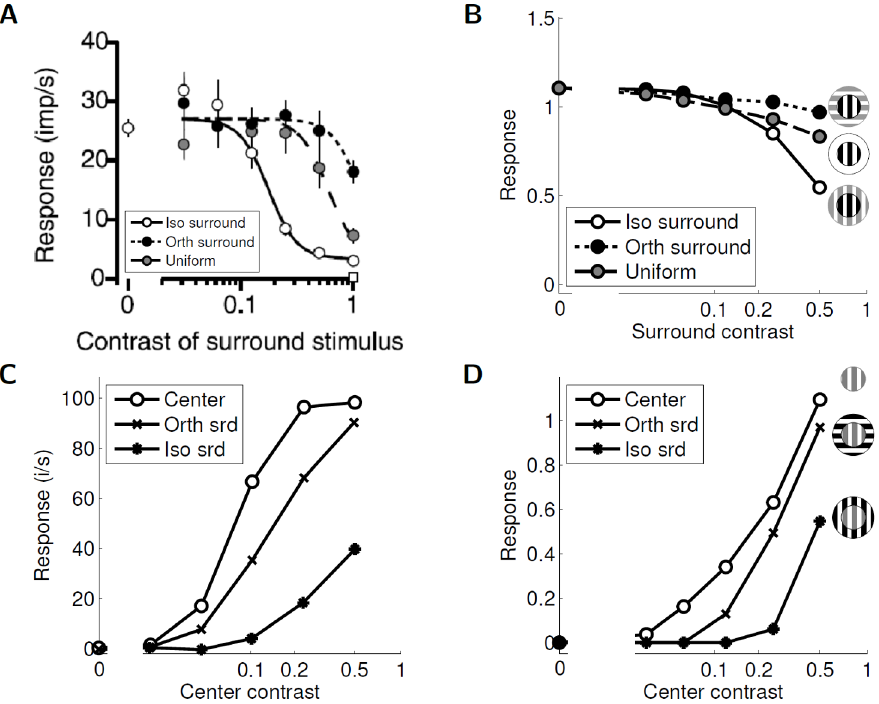
Figure 6. The effect of contrast on surround influences. (A) Surround contrast tunings with fixed center contrast in macaque V1 and varying surround stimuli (reprinted by permission from the Society for Neuroscience: The Journal of Neuroscience, Figure 6B from [35]). The gray markers correspond to responses to a uniform surround at different contrast. (B) Surround contrast tunings with fixed center contrast in the sparse coding model. As with the neuron responses in (A), the model cell is most suppressed for iso-oriented surround stimuli at high contrast. (C) Center contrast tunings with fixed surround contrast in macaque V1 simple cells with varying surround orientations (data replotted from [43], Figure 5A). (D) Center contrast tunings with fixed surround contrast in the sparse coding model. As with the neuron responses in (C), the model cell shows that (especially at high contrast) an iso-oriented surround (asterisk markers) is more effective than an orthogonal surround (cross markers) at suppressing the response to the center alone (white circle markers). As mentioned in the text (see Discussions), the lack of contrast saturation in the present sparse coding model is evident in this figure by the model response at high contrast.